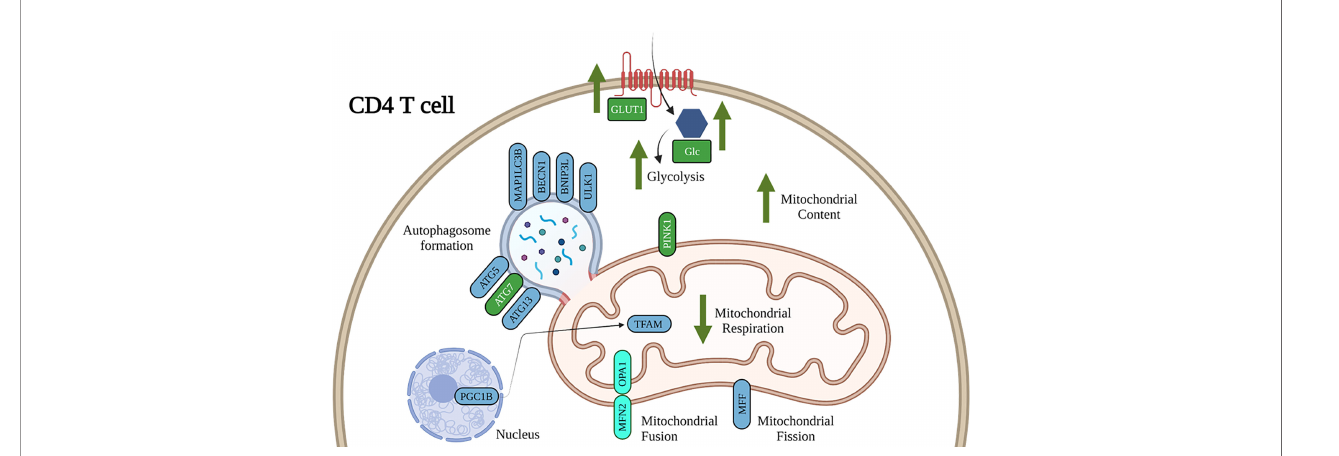
FIGURE 9 | Working model of the impact of ethanol on CD4 + T cell energy metabolism and mitochondrial dynamics. Our results show that ethanol increases CD4 + T cell glycolytic processes, decreases mitochondrial respiration, and dysregulates gene expression important for CD4 + T cell mitochondrial maintenance and mitophagy. Blue denotes gene expression affected by DIFF and green denote gene expression affected by EtOH. Cyan denotes gene expression affected by both DIFF and